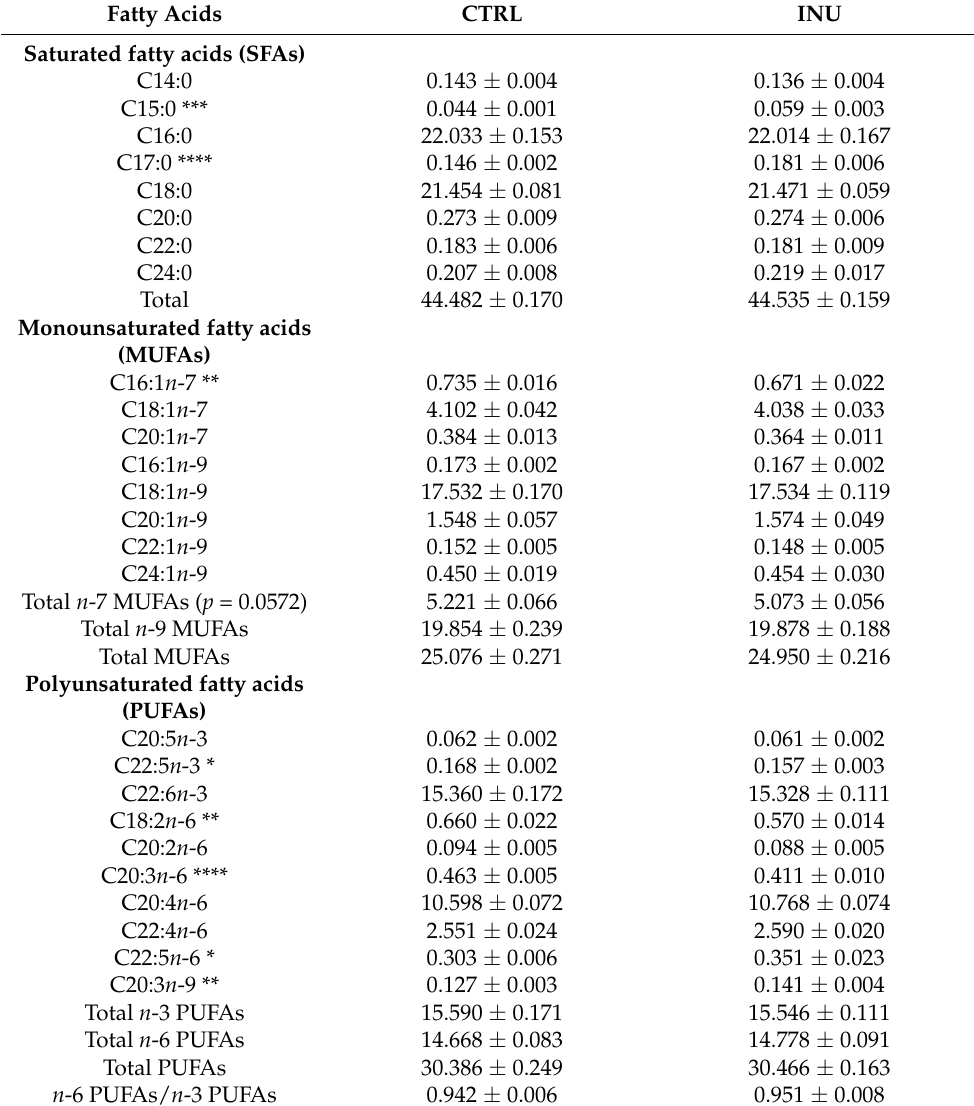
Table 3. Relative abundance of ester-linked fatty acids in the cortex. Fatty Acids CTRL INU Saturated fatty acids